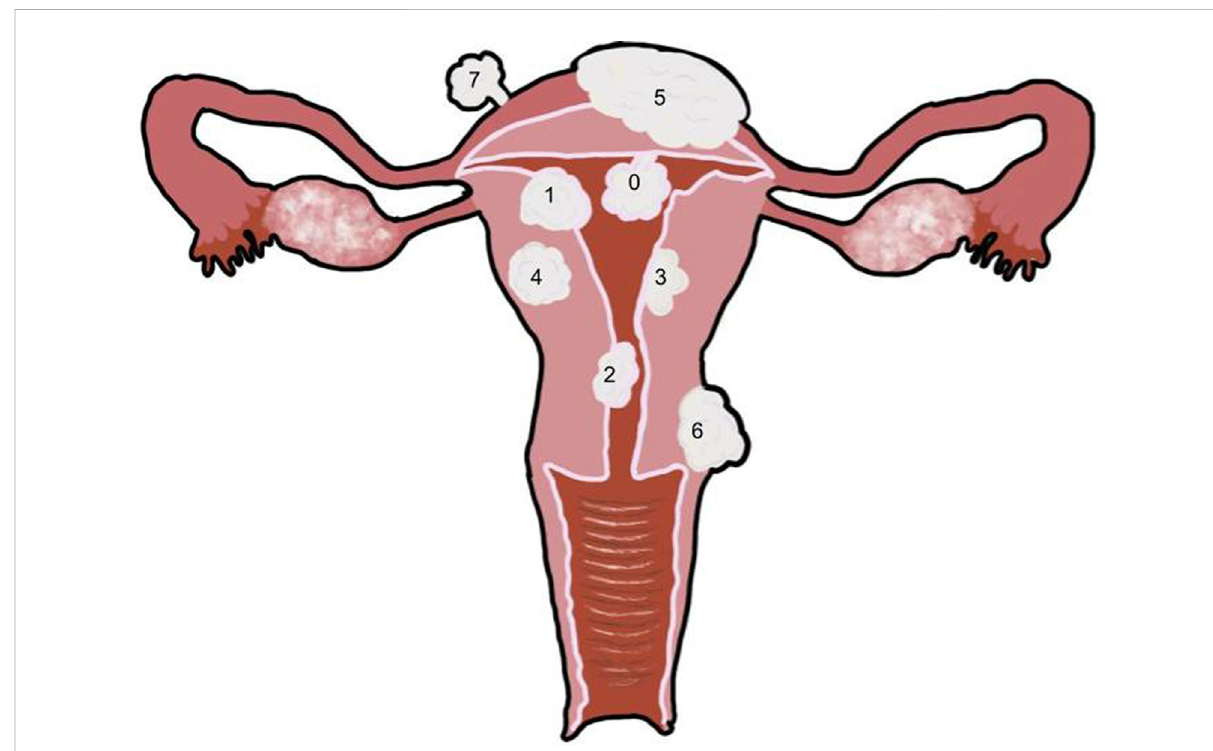
FIGURE 2 Uterus with multiple fi broid types 0: Pedunculated submucosal, 100% of the fi broid is in the uterine cavity. 1: Submucosal, greater than 50% of the fi broid is within the myometrium and the other portion is distorting the endometrium and uterine cavity. 2: Submucosal, less than 50% of the fi broid is within the myometrium and the majority is distorting the endometrium and uterine cavity. 3: Intramural, the fi broid is within the myometrium but touches the endometrium, and it does not distort the uterine cavity. 4: Intramural, the fi broid is completely within the myometrium. 5: Intramural, the fi broid is predominantly within the myometrium with less than 50% extending outside of the myometrium. 6: Subserosal, greater than 50% of the fi broid is located outside of the myometrium. 7: Pedunculated subserosal, 100% of the fi broid is outside of the myometrium. See Table 1 for classi fi cation